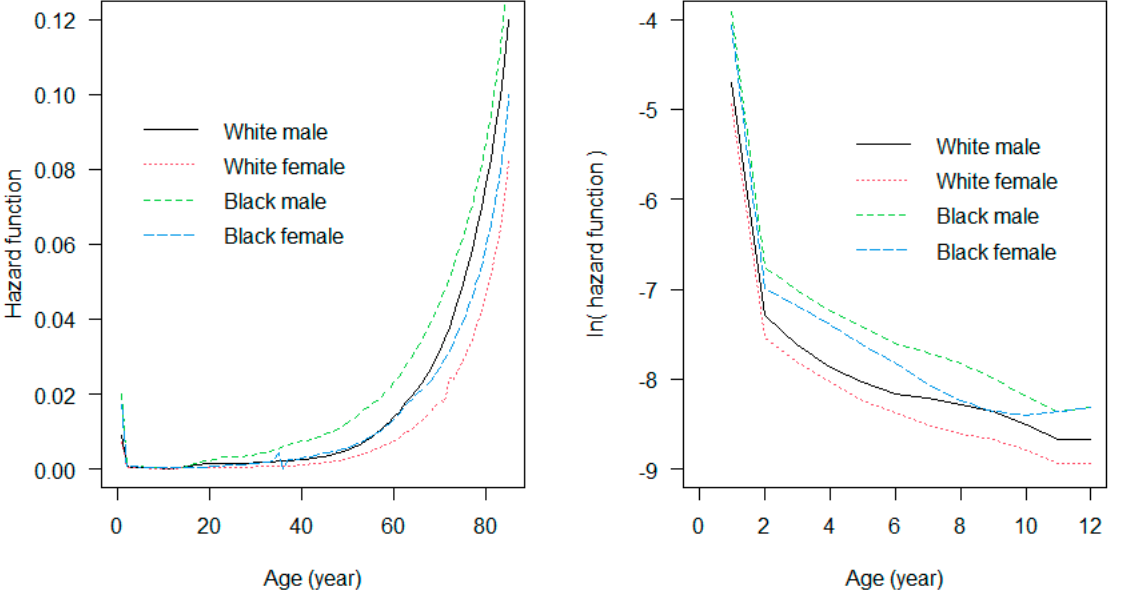
Figure 2. Hazard functions estimated by data from the residents of the United States. The left panel uses the whole range (age 1 to 85), while the right panel uses the restricted range (age 1 to 12).